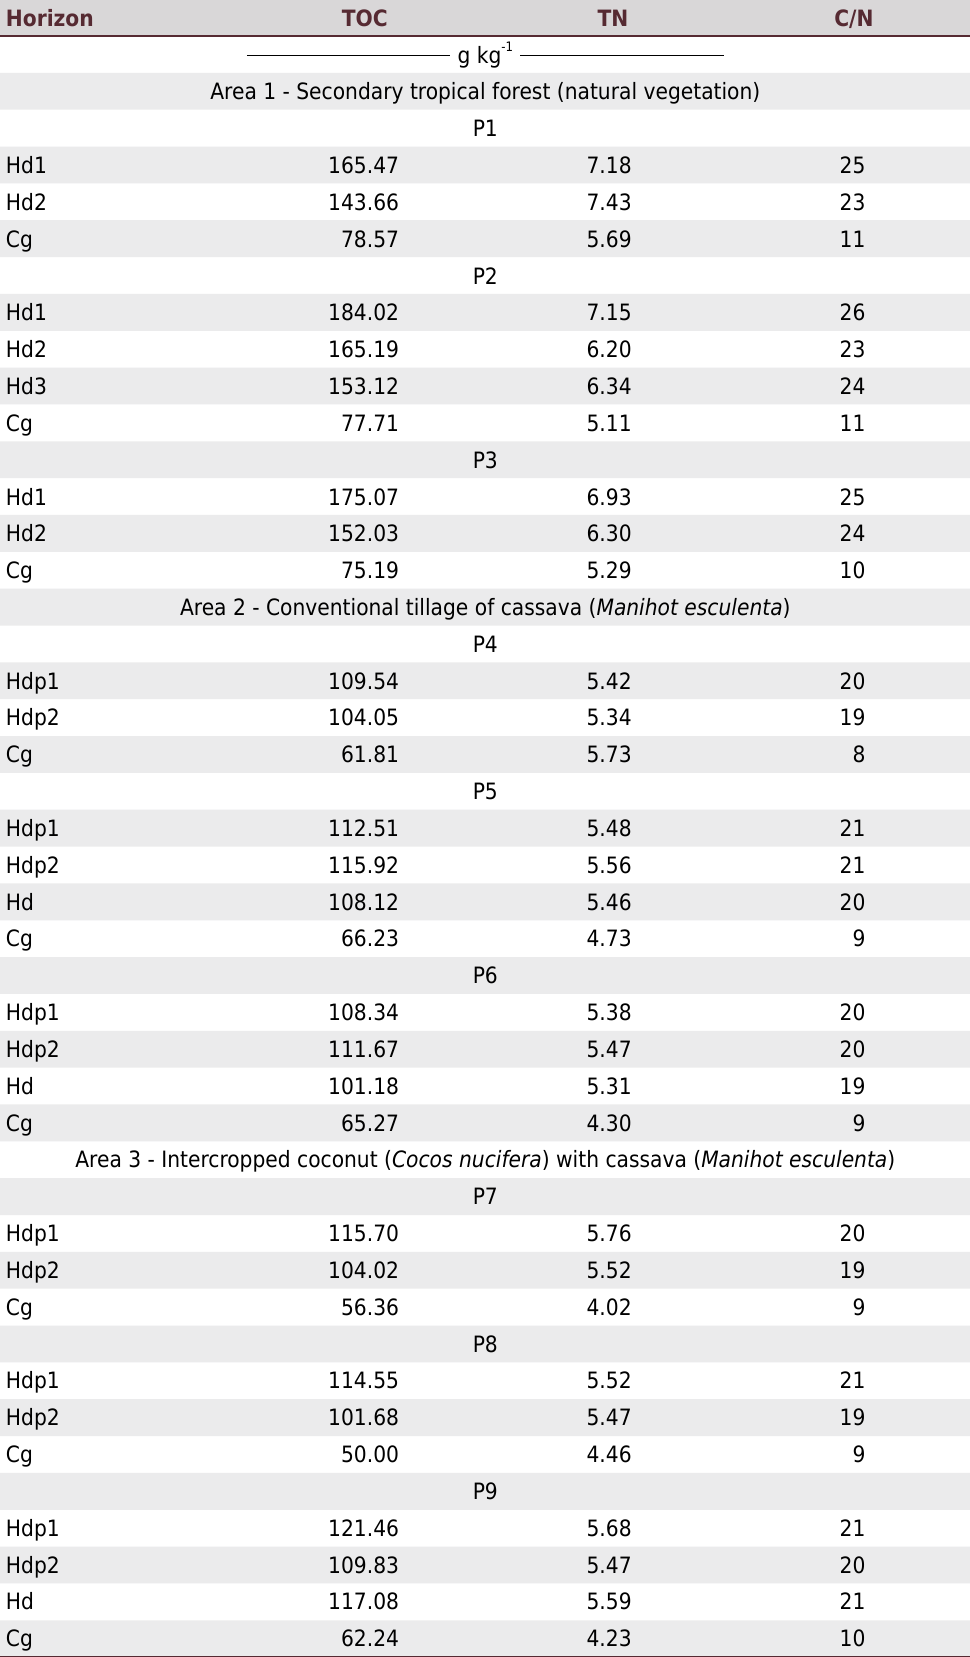
Table 5. Total organic carbon (TOC), total nitrogen (TN), and C/N ratios of the studied Histosol profiles Horizon